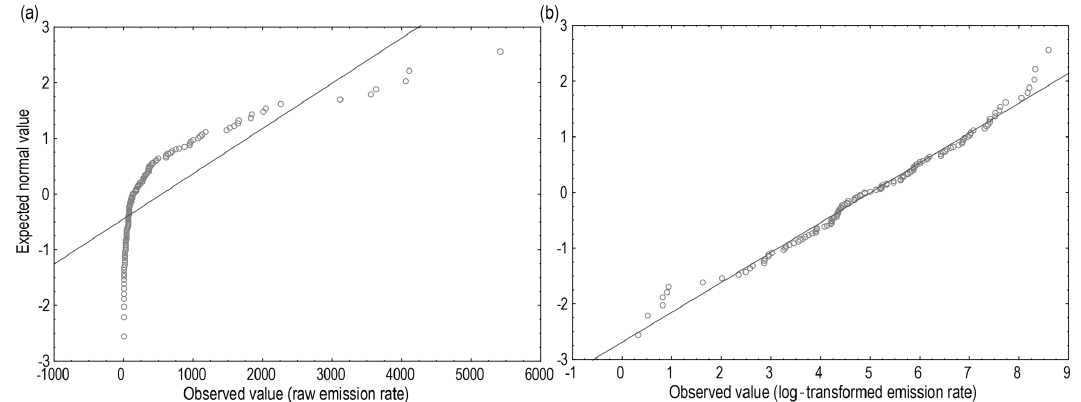
Figure A5. Normal probability plots for (a) raw methane emissions and (b) log-transformed emissions data. The Shapiro–Wilks test p value for raw emissions data was <0.001 and failed the normality test; p value for log-transformed emissions data was 0.081, indicating data were normally distributed.